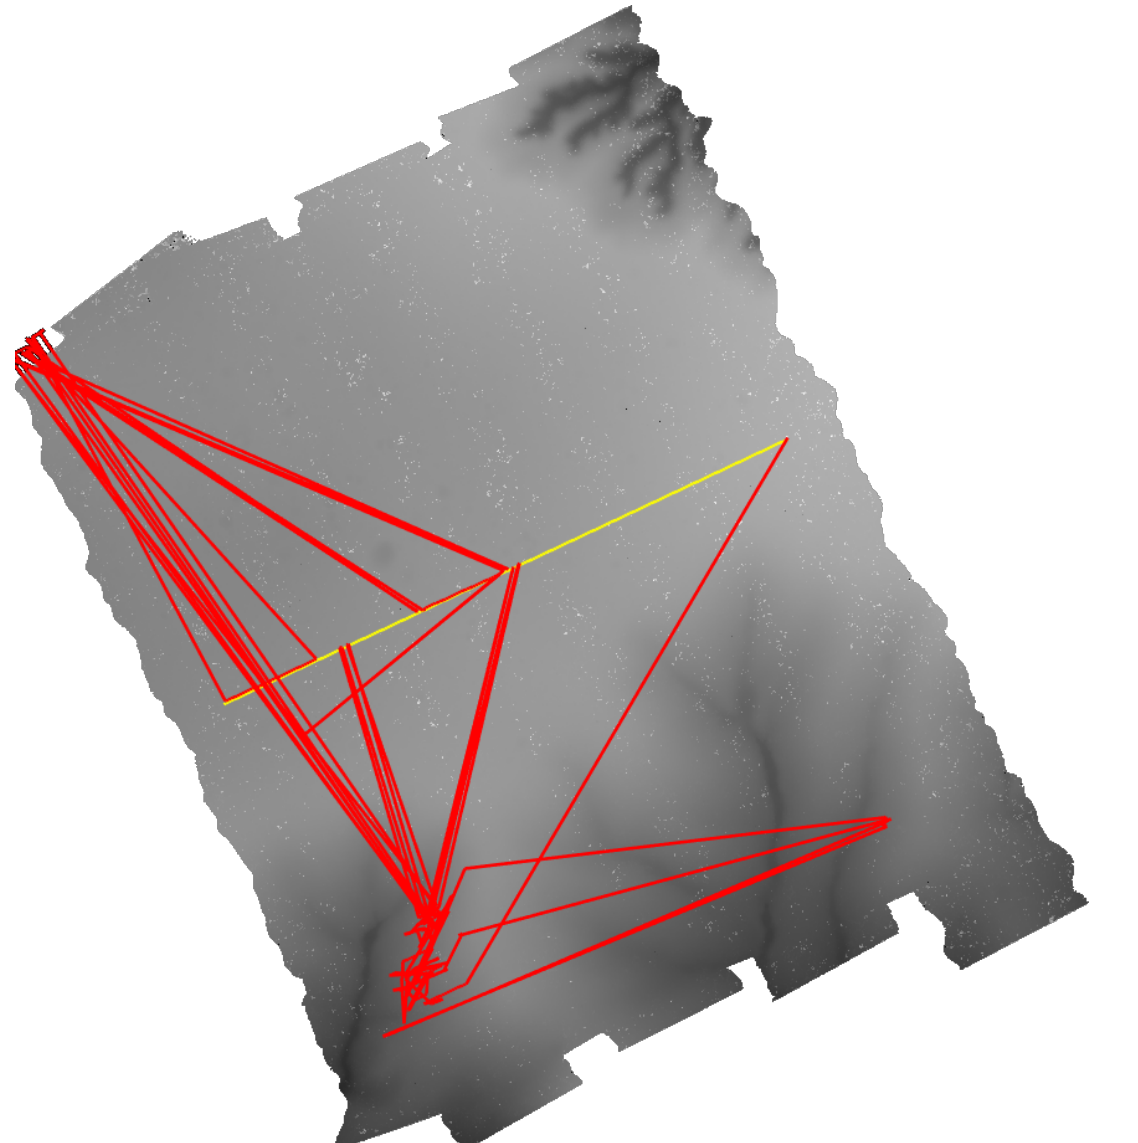
Figure 17. Trajectory in yellow on terrain, square bin, experiment. Corresponding estimated positions are drawn in